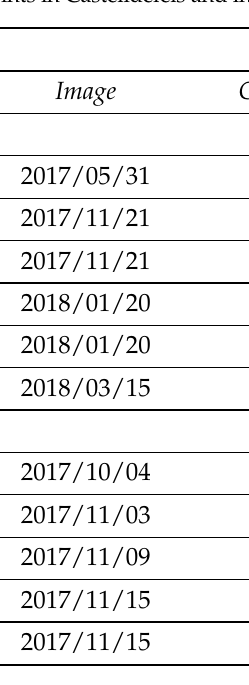
Table 4. Mean and standard deviation of the distances between Sentinel-1 shorelines and GNSS reference points in Castelldefels and in Somorrostro beaches by using the experimental J-Net Dynamic